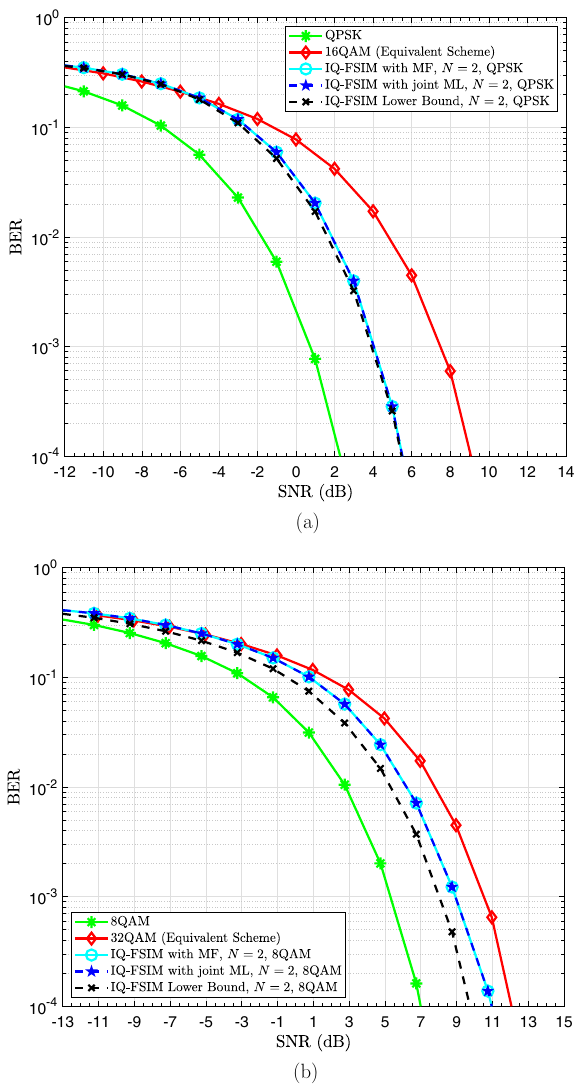
Fig. 9 BER performance for 2-IQ-FSIM- M QAM, its theoretical lower bound, and its equivalent scheme 4 M QAM of the same SE: a 4 bpcu using M = 4 , b 5 bpcu using M =